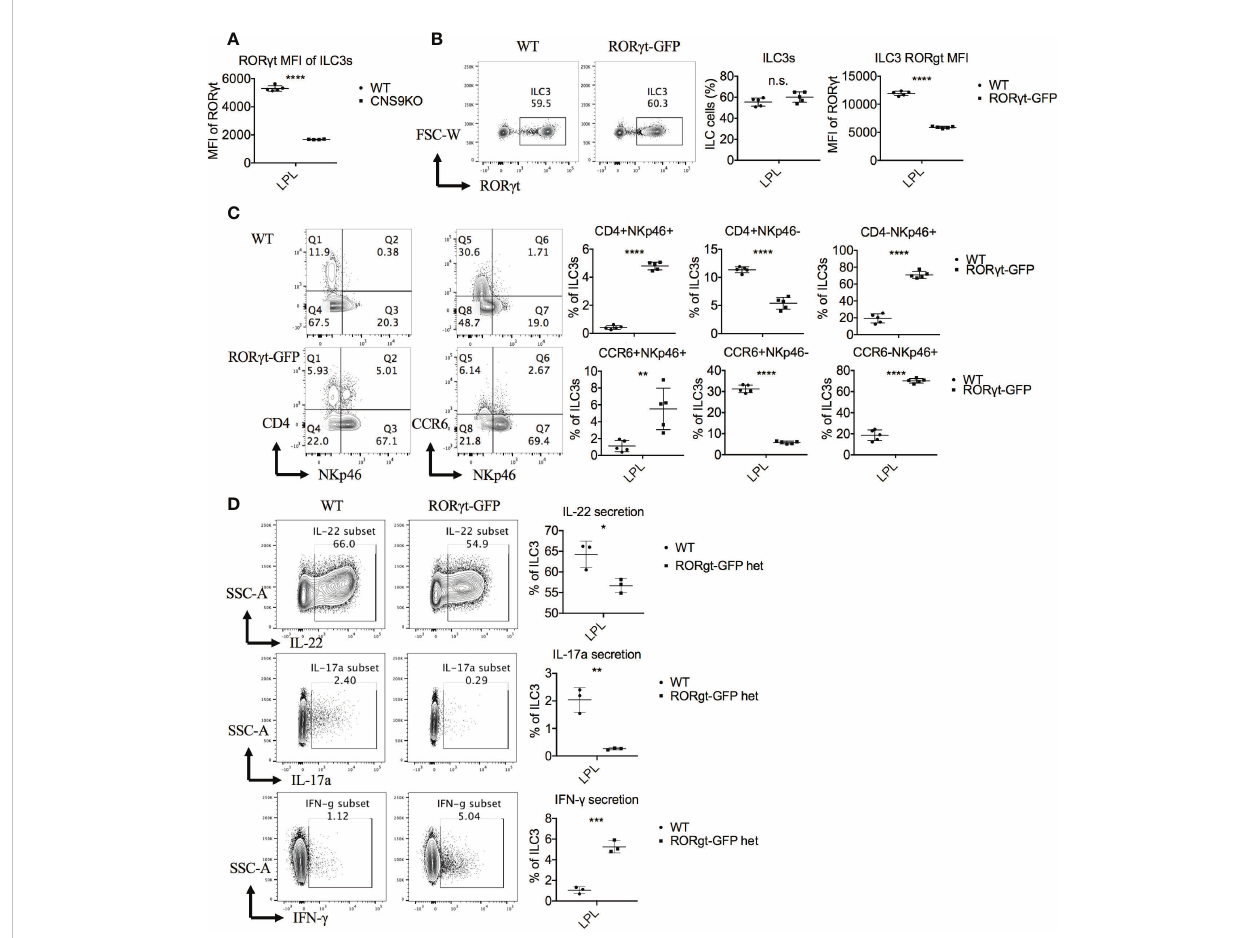
FIGURE 5 ROR g t expression levels regulate the generation of the CD4 + NKp46 + ILC3 subset. ILC3s were isolated from small intestine LPLs of age- and sex- matched WT and CNS9-de fi cient mice (A) or ROR g t GFP mice (B – D) under steady state. Stimulated ex vivo for 4 hours before staining with surface markers, ROR g t and cytokines, and then analyzed by fl ow cytometry. (A) MFI of ROR g t in WT and CNS9-de fi cient ILC3s. (B) Left: intracellular staining of ROR g t (pre-gated on Live CD45 + CD3 - CD90 + ); right: statistic of the staining data and MFI of ROR g t. (C) Left: surface staining of CD4, NKp46 and CCR6 of ILC3s; right: statistic of the staining data. (D) Left: intracellular staining of IL-22, IL-17A and IFN- g after stimulation (pre-gated on ILC3s: Live CD45 + CD3 - CD90 + ROR g t + ); right: statistic of the staining data. The data shown are a representative of three independent experiments and presented as mean ± SD. Also see Figures S4 and S5. Statistical signi fi cance was calculated using unpaired Student ’ s t test and shown as *p < 0.05; **p < 0.01; ***p < 0.001, ****p < 0.0001 or n.s. (non-signi fi cant) p >